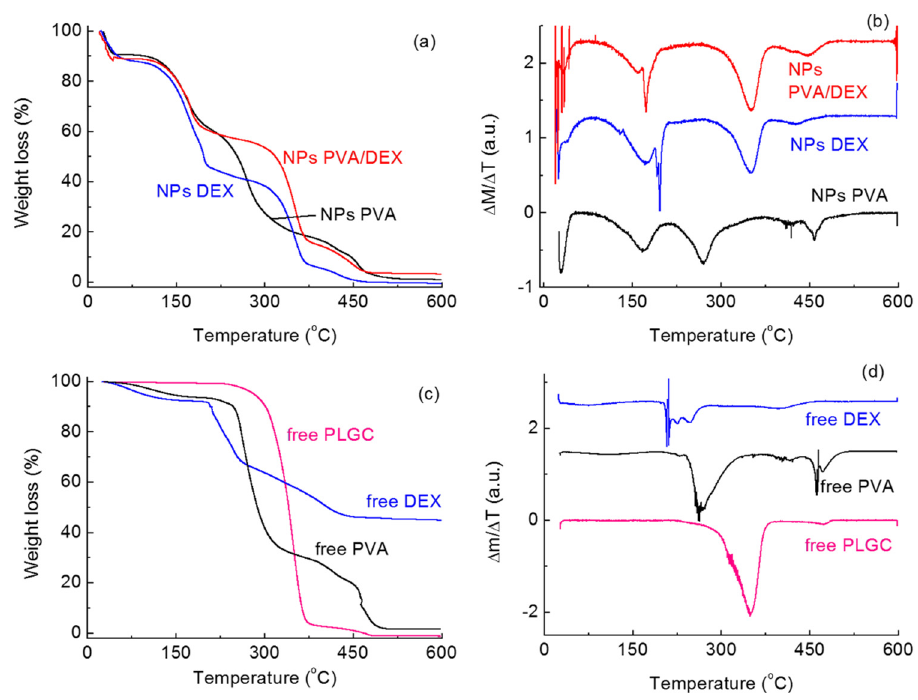
Figure 2. ( a ) TGA curves and corresponding ( b ) first derivatives of the PLCG NPs prepared with the different surfactants; ( c ) TGA curves and corresponding ( d ) first derivatives of free PLGC polymer and surfactants.